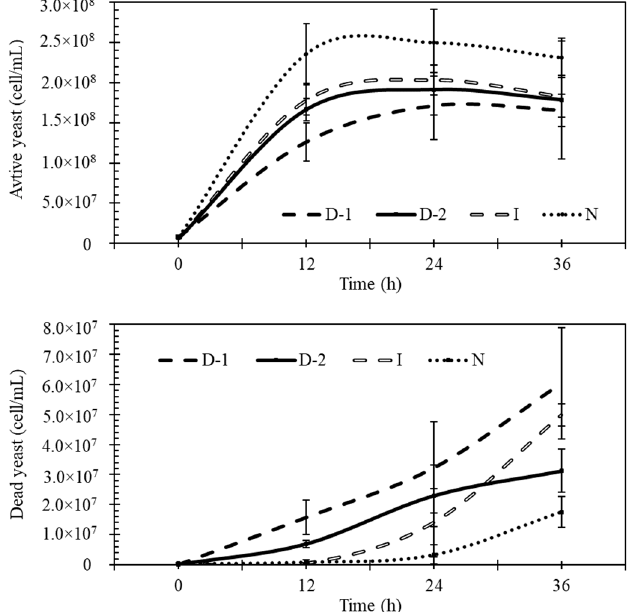
Figure 6. Effects of ultrasound on concentrations of active and dead yeast cells during fermentation. No-ultrasound (N), indirect ultrasound (I), direct ultrasound 1 (D-1), and direct ultrasound 2 (D-2).